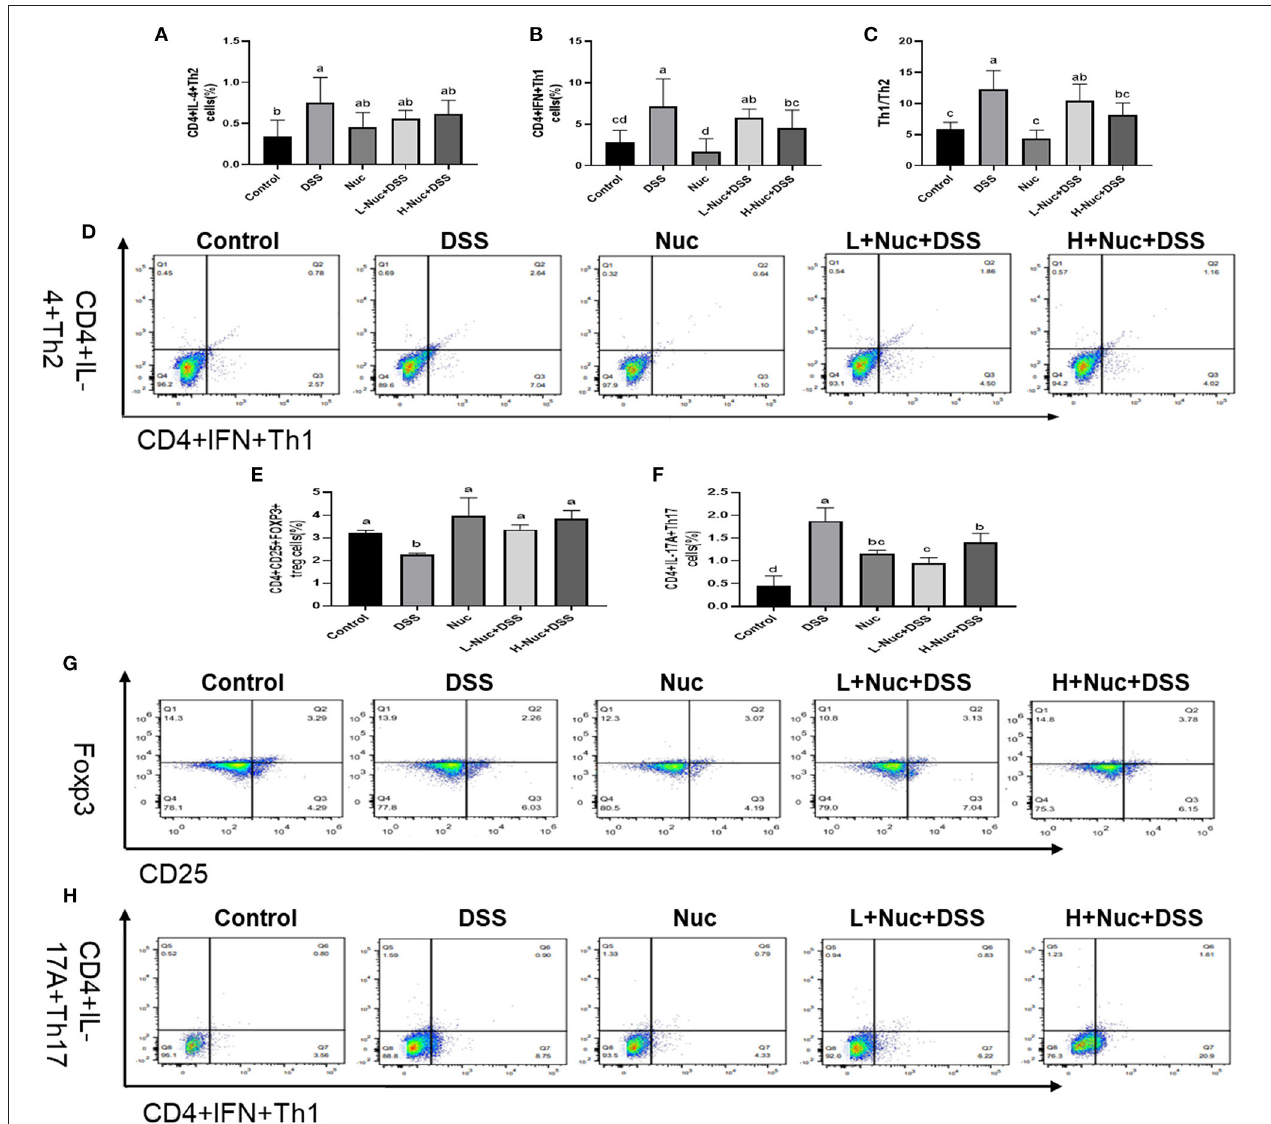
FIGURE 4 | Nuciferine restored the balance of Th1/Th2 Th17/Treg cells ( n = 6). (A) The percentage of IL-4 cells in the spleens. (B) The percentage of IFN cells in the spleens. (C) The Th1/Th2 ratio in the spleens. (D) Flow cytometry of IL-4 and IFN in the spleens. (E) The percentage of Tregs cells in the spleens. (F) The percentage of Th17 cells in the spleens. (G) Flow cytometry of Tregs in the spleens. (H) Flow cytometry of Th17 in the spleens. The data are expressed as the mean ± S.D. Significant differences were considered at P < 0.05. a − d Bars without the same superscripts differ significantly ( P < 0.05).